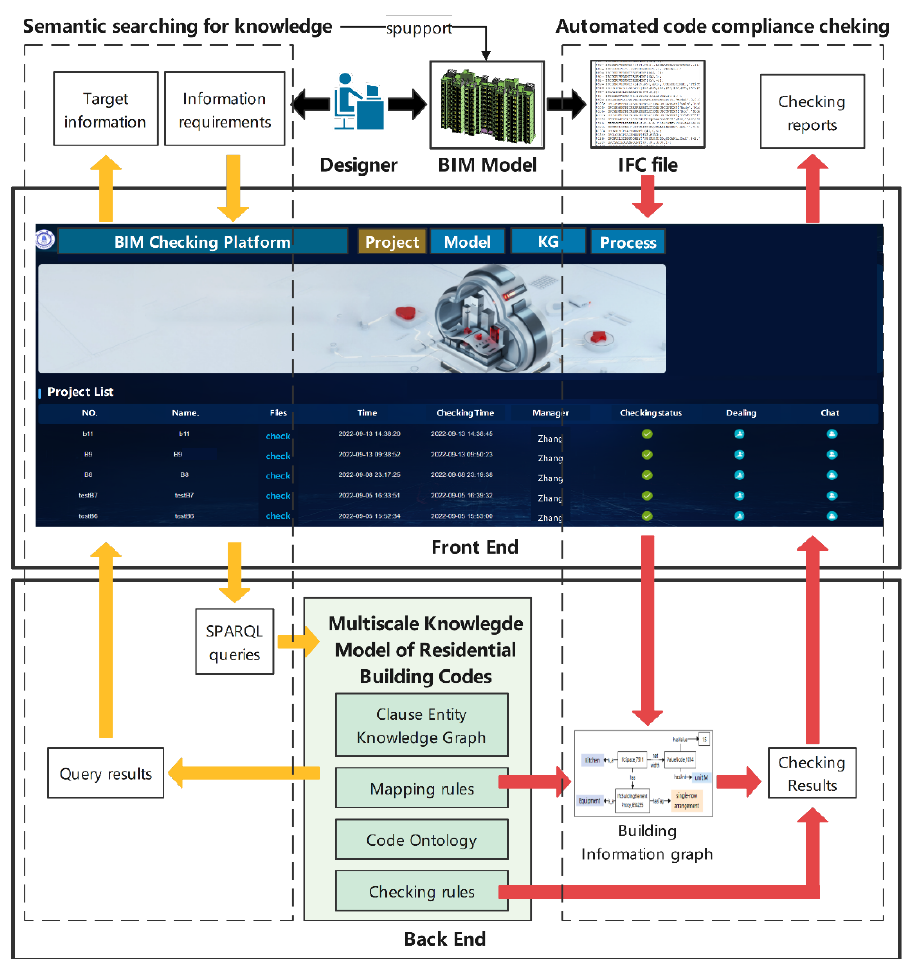
Figure 12. Framework of the platform developed based on the multiscale knowledge model of the residential building codes.